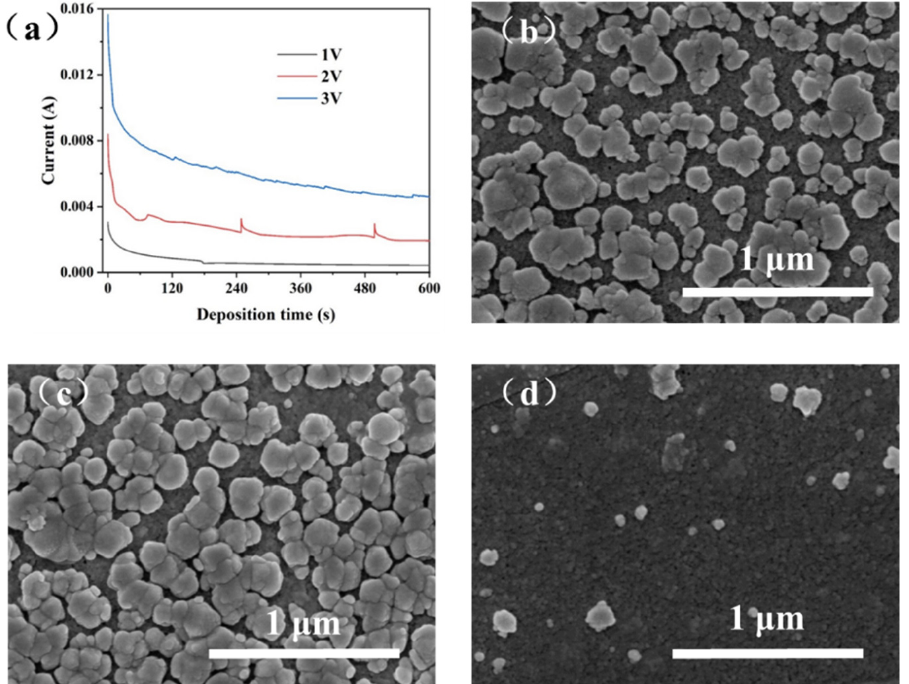
Figure 4. ( a ) The current–time curve under different constant voltages; SEM images of ZIF-8 particles on support: ( b ) 1 V, ( c ) 2 V, ( d ) 3 V (molar ratio of zinc ion to 2-methylimidazole: 1:75, deposition time: 10 min).